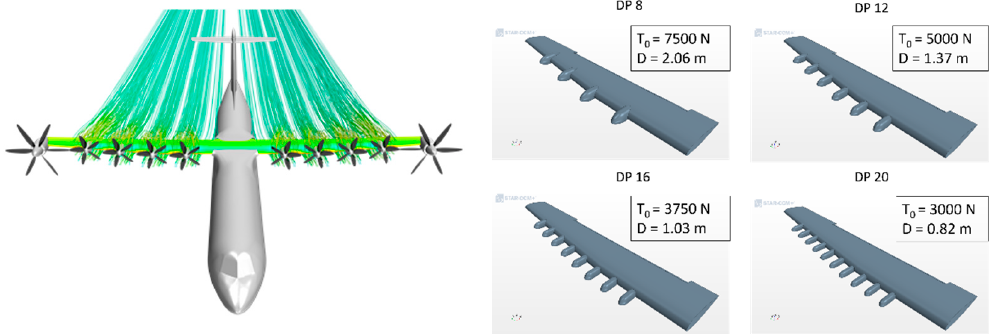
Figure 24. High-lift propeller on a typical 40-passenger regional turboprop wing, AR = 11.07, M = 0.15, Re = 7.6 × 10 6 , DEP 8, DEP 12, DEP16, and DEP 20 configurations, T 0 is the thrust per propeller.